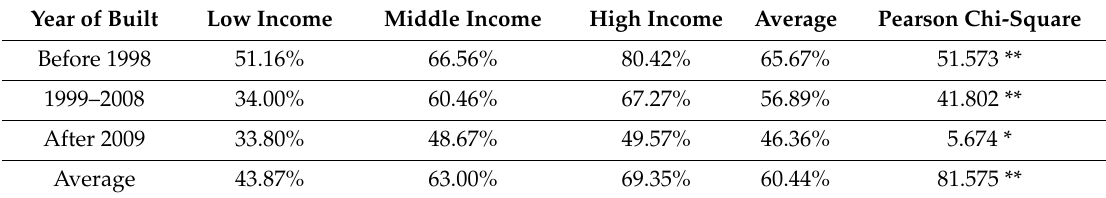
Table 5. Ratio of accessibility in a 10-min walk of di ff erent housing attributes in Nanjing. Year of